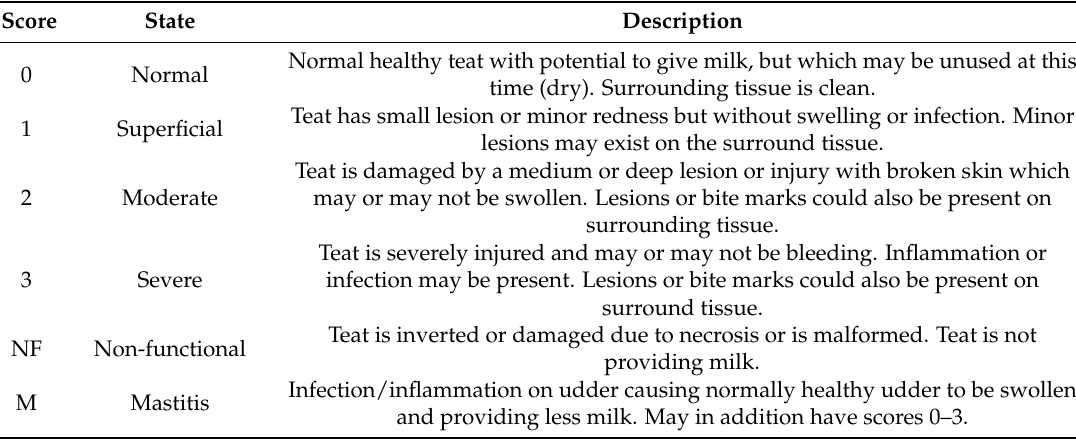
Table 1. Teat damage